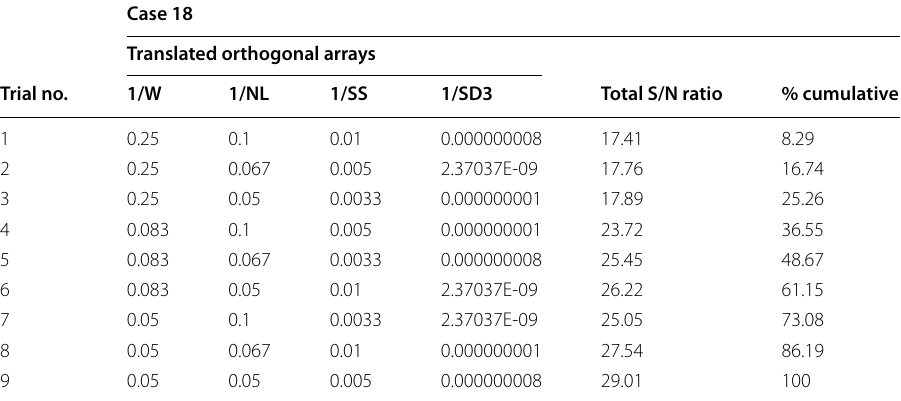
Key: Boron nitride ( W ), %wt; normal load ( NL ), N; sliding speed ( SS ), rpm; sliding distance ( SD ),